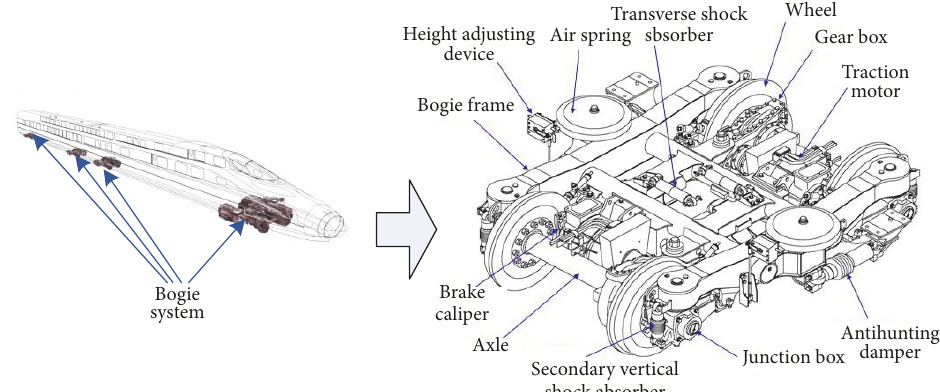
Figure 3: The flow chart of the proposed method.